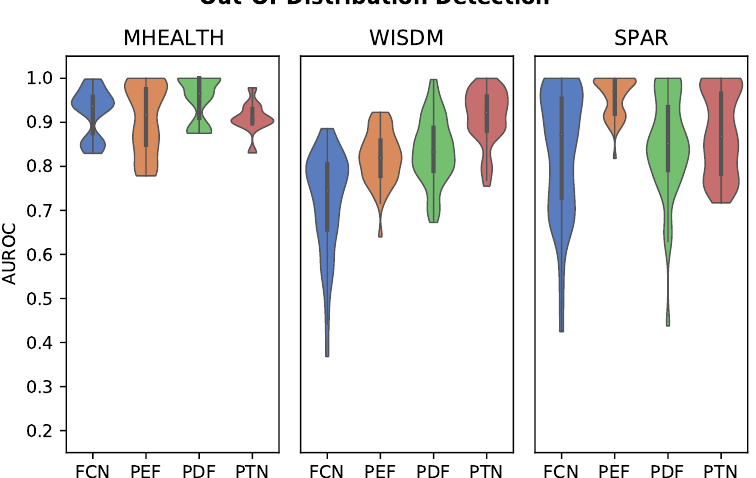
Figure 5. Violin plots showing distribution of OOD detection AUROC across subjects, with 30% of activity classes held back from the training set. The displayed distributions are cut-off at the minumum and maximum AUROC values for each classifier. The PDF, PTN, and PEF classifiers had the highest mean AUROC scores for the MHEALTH, WISDM, and SPAR datasets, respectively.